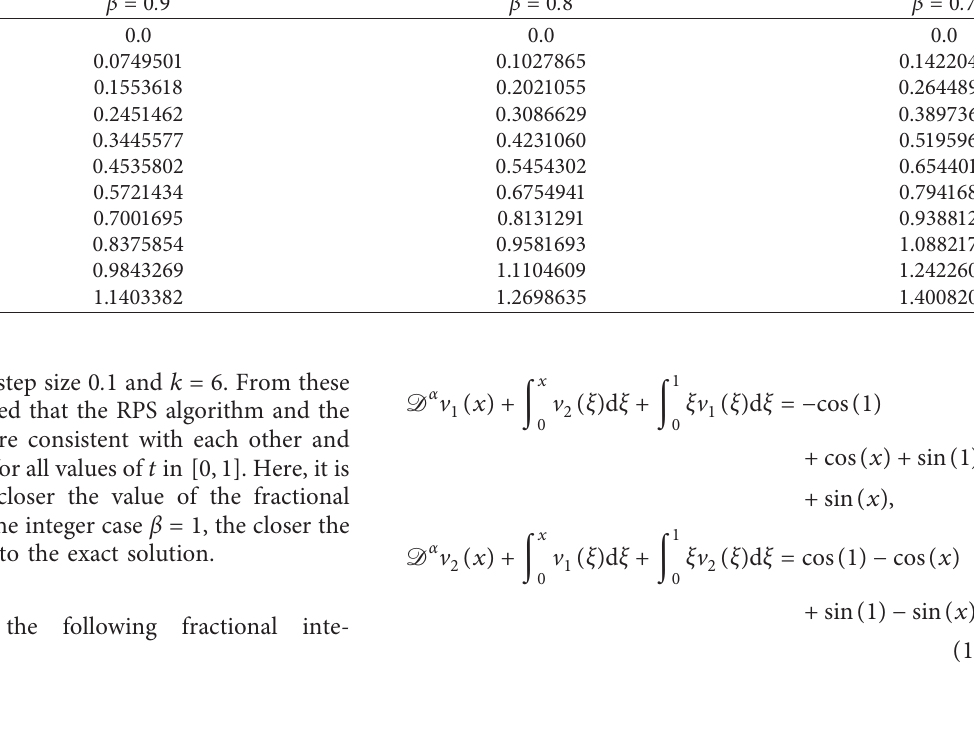
Table 7: Numerical results of approximate solution v